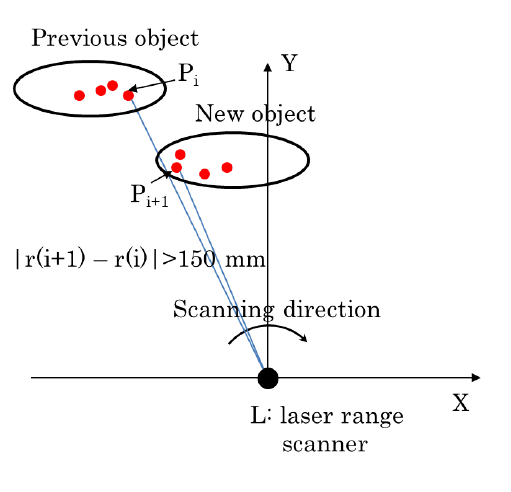
Fig. 8. Object Extracting from Data Array r ( i